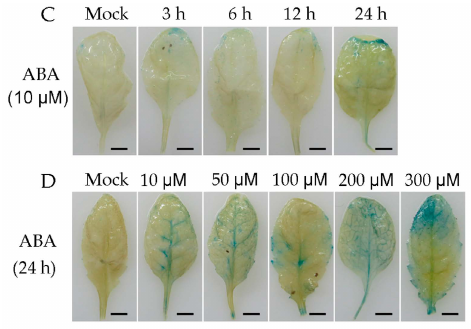
Figure 6. Effect of ABA on HbMFT1::GUS activity in transgenic Arabidopsis . ( A , C ) The phenotypes of seedlings and rosette leaves of transgenic Arabidopsis treated with 10 µ M ABA for 3, 6, 12 and 24 h, respectively; ( B , D ) The phenotypes of seedlings and rosette leaves of transgenic Arabidopsis treated with different concentrations of ABA (10, 50, 100, 200 and 300 µ M) for 24 h. Both of the transgenic Arabidopsis plant lines with HbMFT1::GUS fusions were sampled independently twice. Bar = 1 mm for ( A , B ); bar = 3 mm for ( C , D